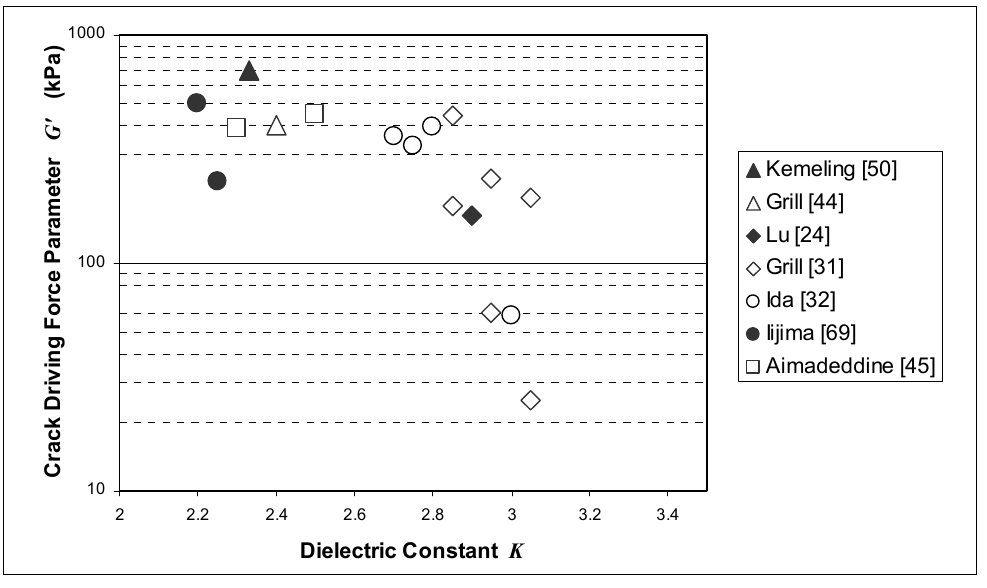
Figure 5. Crack driving force parameter G ' defined in equation (6) plotted versus dielectric constant K for several carbon-doped oxide films including non-porous CVD SICOH, porous CVD ULK SiCOH, and porous spin-on